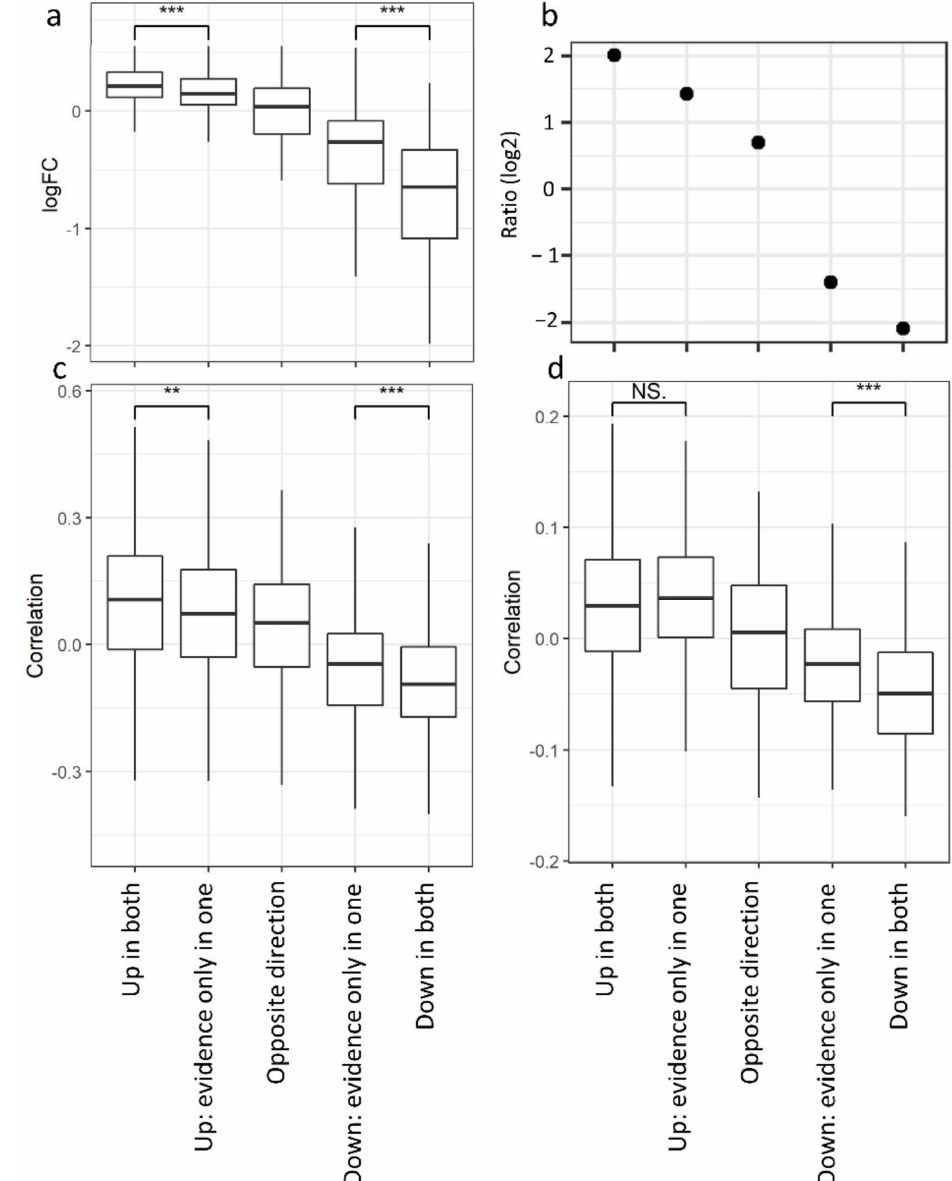
Figure 3. The 5 classes of DEGs in bulk samples. Genes regulated in both tumor epithelium and stroma, significantly regulated only in one of the two compartments and with opposite regulation in the two compartments show different degrees of: ( a ) differential expression between tumor and normal samples in the bulk samples of the TCGA cohort; ( b ) ratio between the number of genes significantly correlated with poor prognosis and the number of genes significantly correlated with good prognosis in the METABRIC cohort. High values indicate that many genes are correlated with poor prognosis, while inversely, negative values indicate that many genes are correlated with good prognosis; Spearman’s correlation with tumor grade ( c ) and size ( d ). Significance was assessed with the Wilcoxon test (** <0.01, *** <0.001, NS = Not